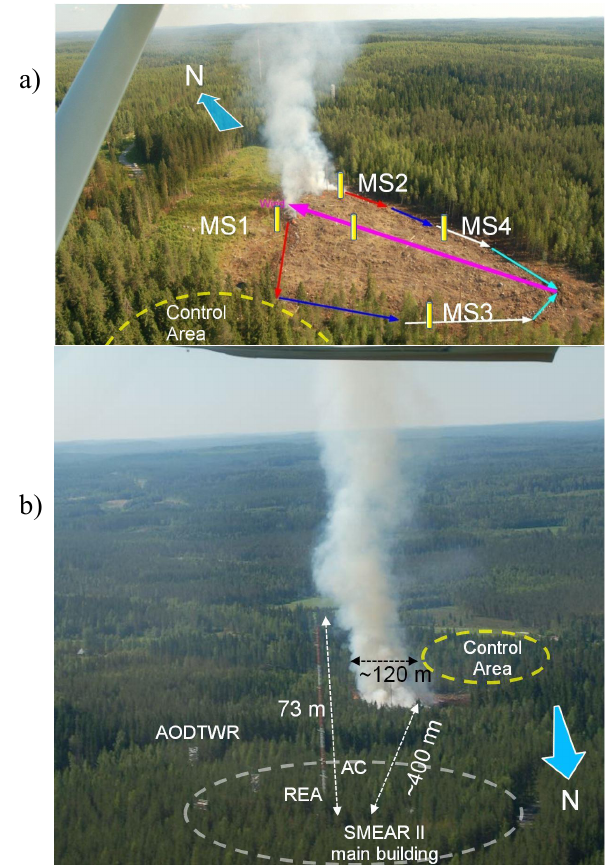
Fig. 1. Aerial photographs of the study site during the flaming phase. (a) From the south, with the progress of the ignition de- scribed by the red, blue, white and light blue arrows, and the av- erage wind direction by the pink arrow. The yellow bars denote the poles (not in scale) with meteorological sensors (MS1–MS4) on top. (b) From the north at approximately 300m above ground level. The majority of the aerosol and gas measurement instrumentation of SMEAR II is located within the dashed white oval. The control area is within the yellow oval. The blue arrow points approximately north. AC: aerosol cottage; REA: relaxed eddy accumulation cot- tage; AODTWR: Aerosol Optical Depth